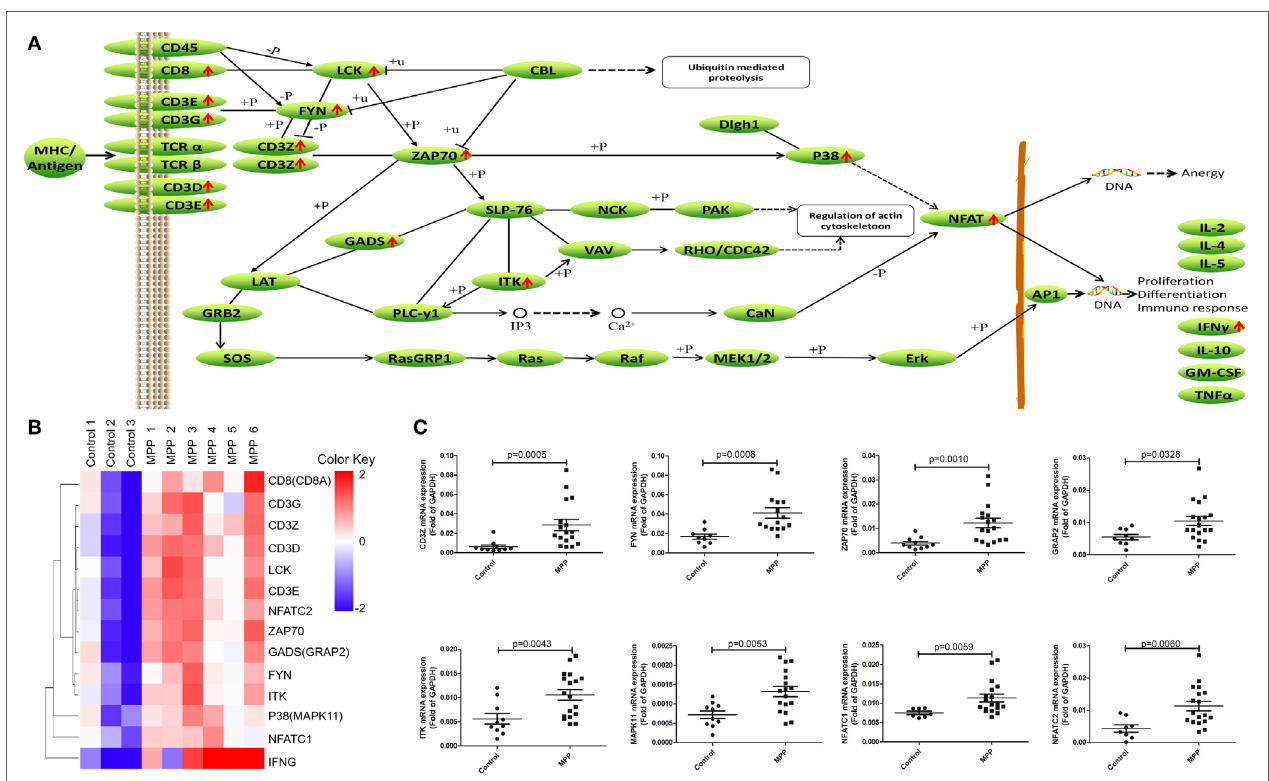
FigUre 6 | Differential expression genes (DEGs) mapped to T cell receptor signaling pathway Kyoto encyclopedia of genes and genomes pathway. (a) Model diagram showing T cell receptor signaling pathway, red arrows indicate upregulated gene expression. (B) Cluster analysis of DEGs that mapped to T cell receptor signaling pathway. (c) Quantitative real-time PCR validation of DEGs mapped to T cell receptor signaling